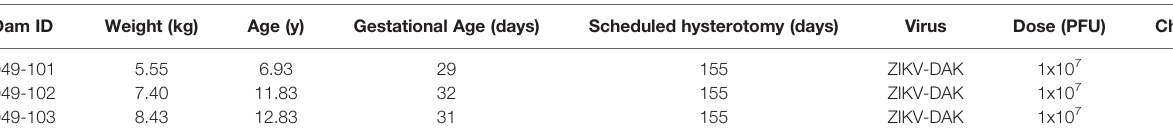
TABLE 1 | Dam information on day 0 of